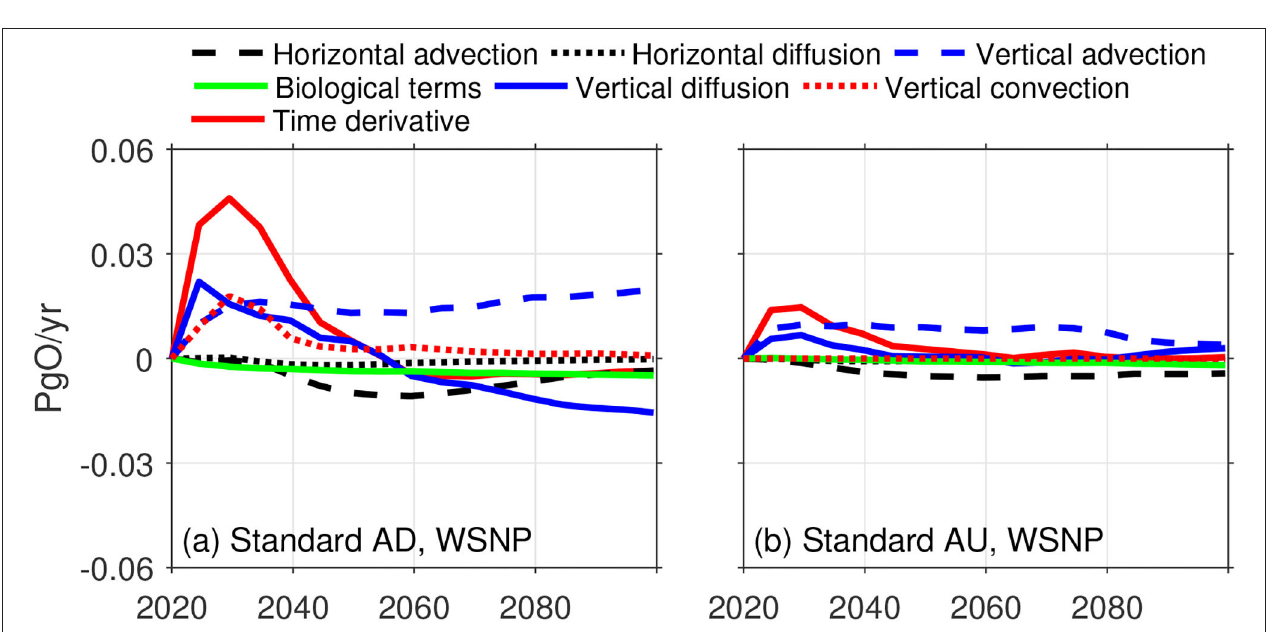
FIGURE 4 | Basin averaged vertical profiles of oxygen anomaly within the WSNP relative to the reference run after 10 (solid), 30 (dash), and 80 (dotted) years of pipe operating: (a) standard AD; (b) standard AU.